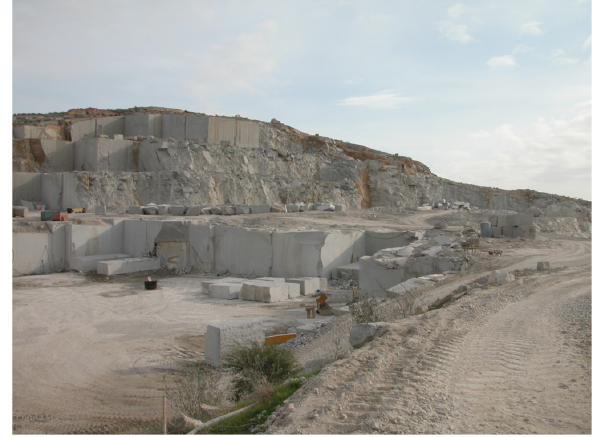
Fig. 4. The Azul Platino and Amarillo Platino quarry. Granite ex- traction is one of the most profitable activities in